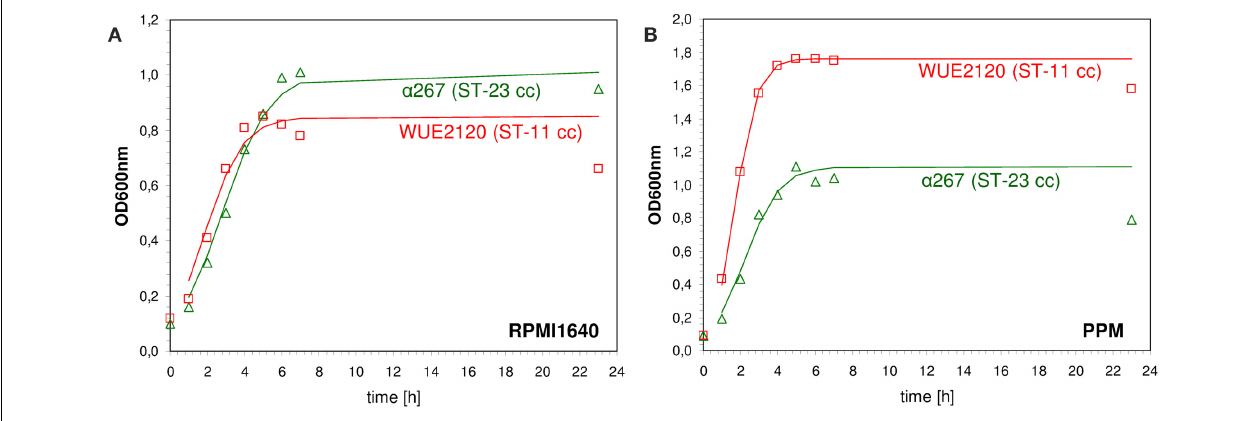
an initial optical density [ OD 600 nm ( t 0 )] of 0.1. A logistic growth model was fitted to the data by according to OD 600 nm ( t ) = K · OD 600 nm ( t 0 ) · e r · t K + OD 600 nm ( t 0 ) · ( e r · t − 1) non-linear regression analysis using R version 2.7.0 and the nls package (R Development Core Team, 2008) to estimate the growth rate r [1/min] and the capacity K ( OD 600 nm in the stationary phase). Red squares: ST-11 clonal complex strain WUE2120, green triangles: ST-23 clonal complex strain α